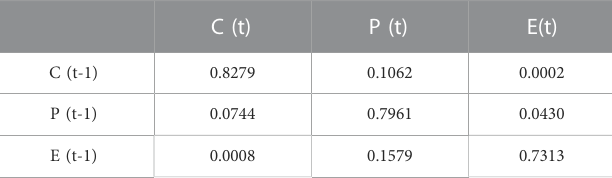
TABLE 7 Transition matrix: discrete model. C, P, and E stand for core, periphery, and exit, respectively. This matrix is calculated by the example of Figure 3. We calculated the transition probability each year and then averaged it during 2000 – 2015.